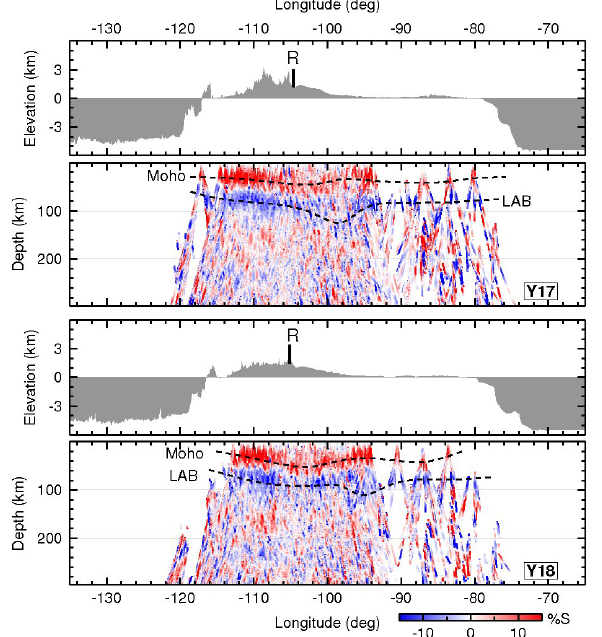
Fig. 11. Migrated S receiver functions along profiles Y17 and Y18 as in Fig. 3. Migrated S receiver functions along profiles Y17 and Y18 as in Fig. 3.